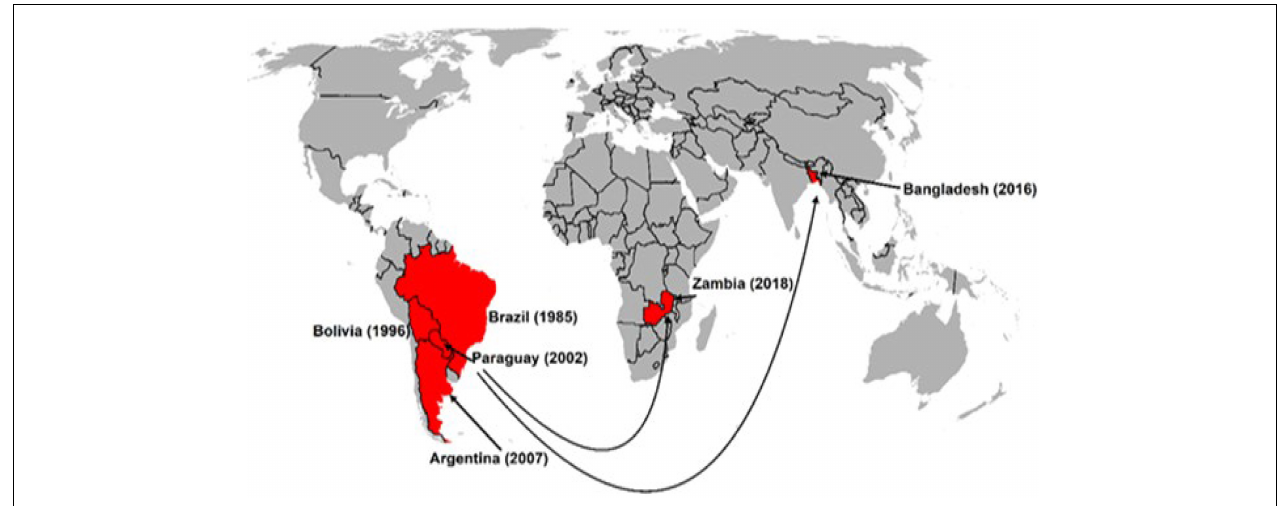
FIGURE 7 | Intercontinental spread of wheat blast attributed to grain